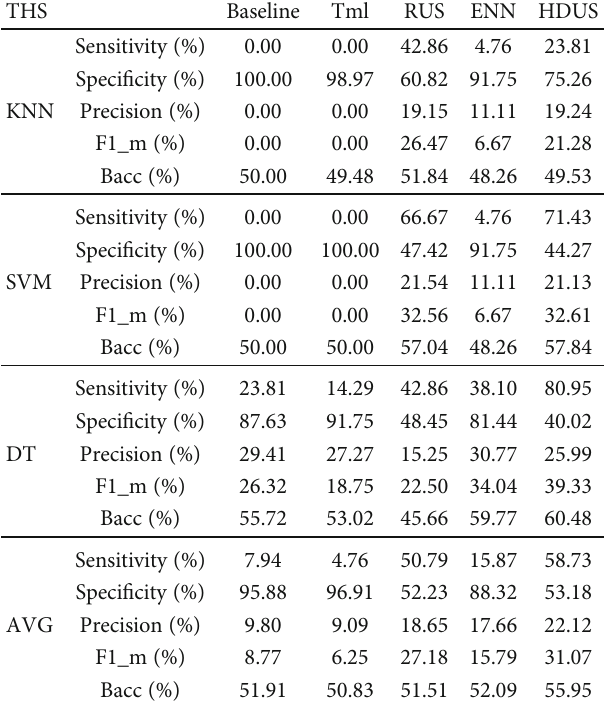
Table 7: Evaluation results for THS dataset using classi fi ers (KNN, SVM, and DT) and models (baseline, Tml, RUS, ENN, and HDUS).